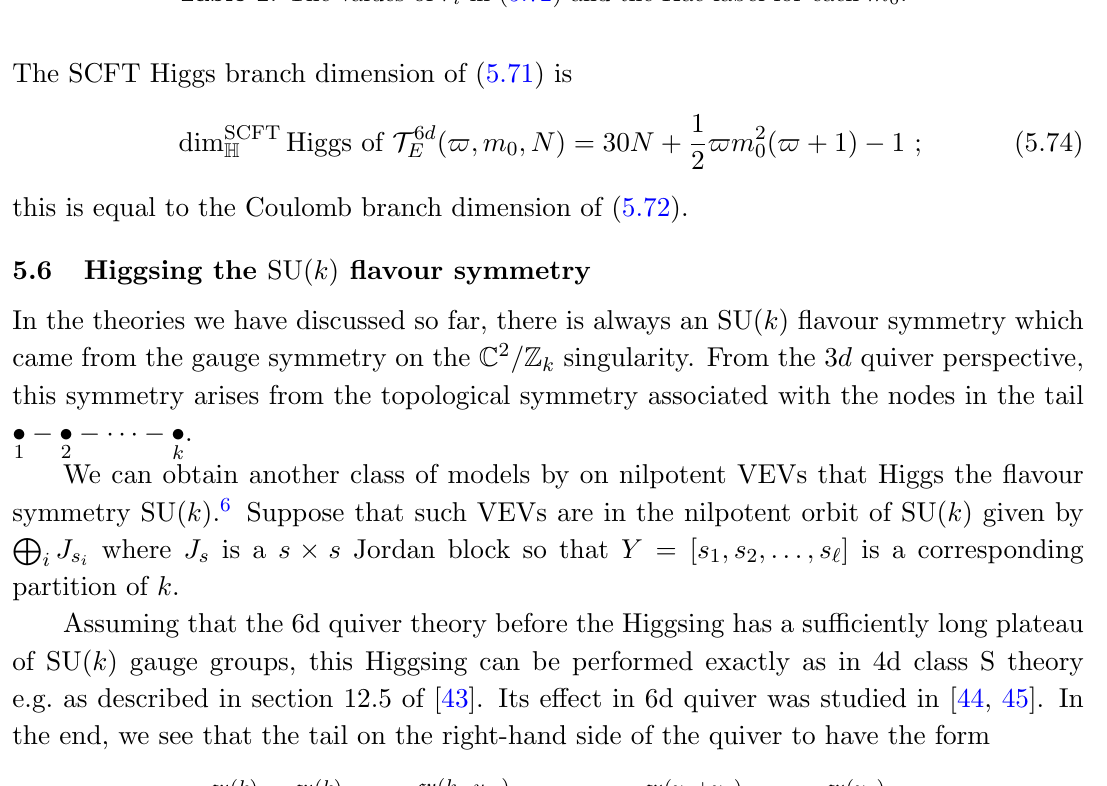
Table 1 . The values of r i in (5.72) and the Kac label for each m 0